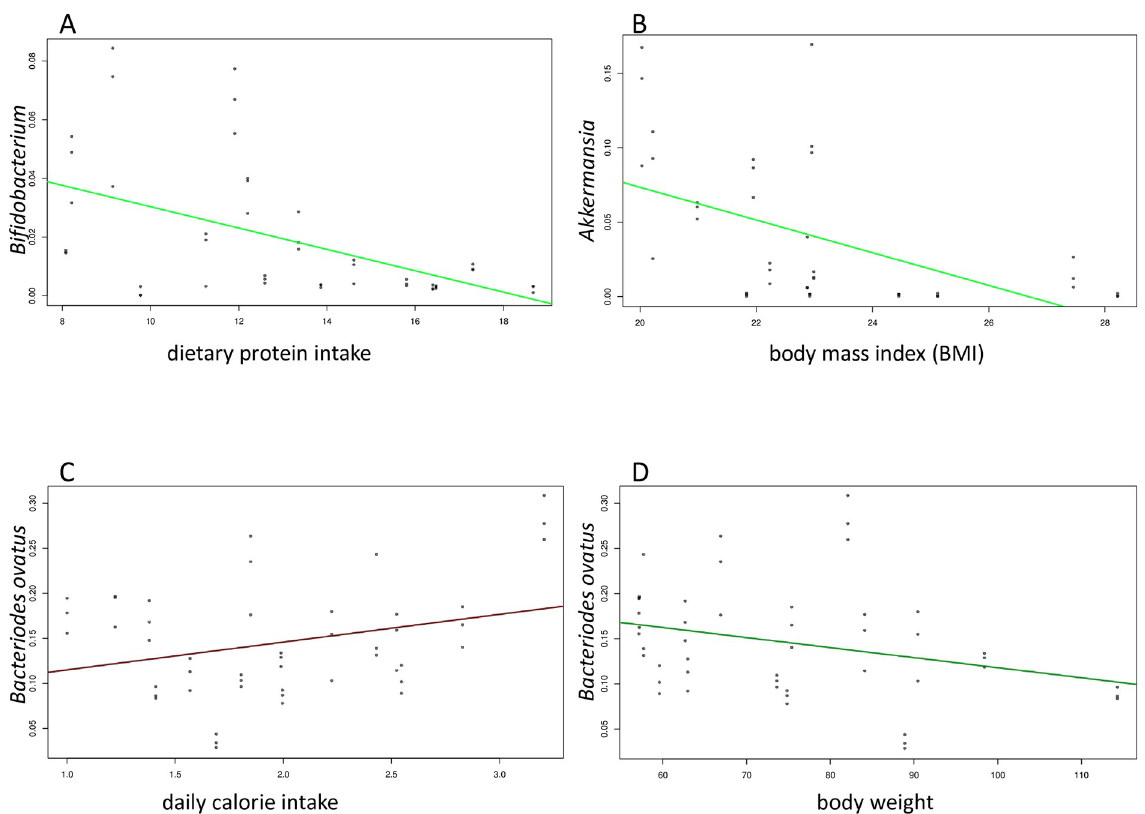
Fig 3. Correlation between bacterial organism and nutrient data. (A) Bifidobacterium is positively correlated with dietary protein intake, specifically vegetable protein, present in vegetables such as broccoli, brussel sprouts, beans, peas, asparagus and beans. (B) Akkermansia is positively associated with body mass index (BMI). (C) Bacteriodes ovatus is positively correlated with daily calorie intake. (D) Bacteriodes ovatus is negatively correlated with body